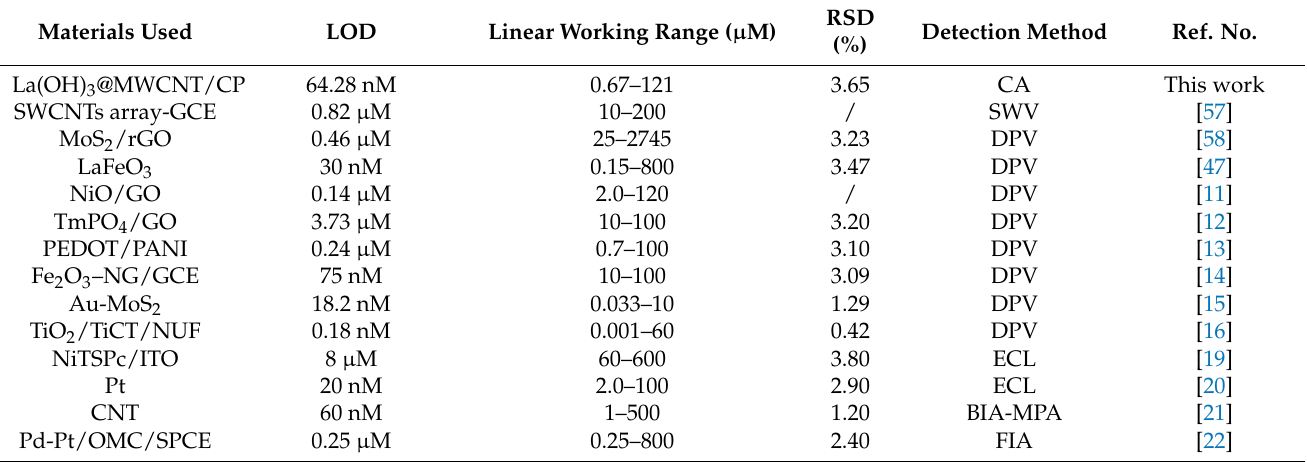
Table 1. An overview of recently reported nanomaterial-based electrochemical methods for the determination of